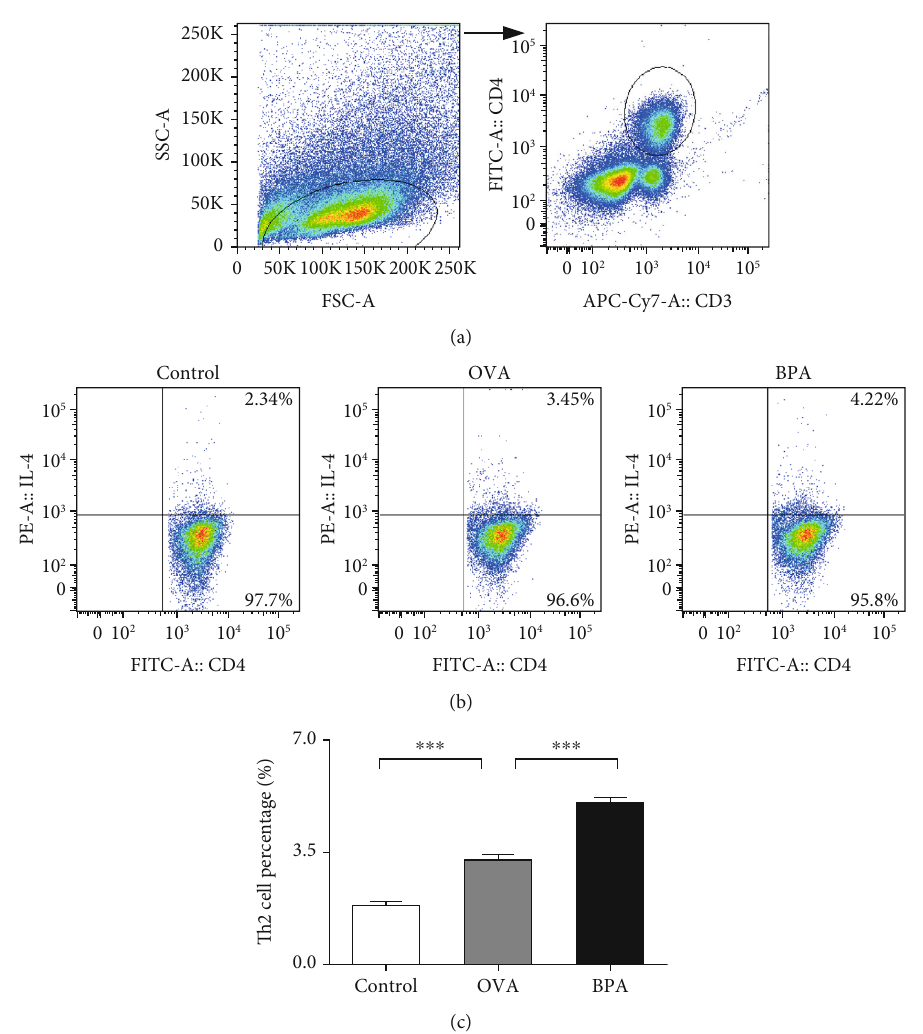
Figure 6: Flow cytometry showed that BPA increased the proportions of Th2 cells in the spleens of mice with OVA-induced AR. CD3 + CD4 + T cell subgroup (a). Representative staining of CD3 + CD4 + IL-4 + Th2 cells of each group. The numbers in the upper right quadrants are the proportions of Th2 cells (b). The statistical data (c). Data are expressed as means ± SEM ; n = 5 in each group. ∗∗∗ P < 0 : 001